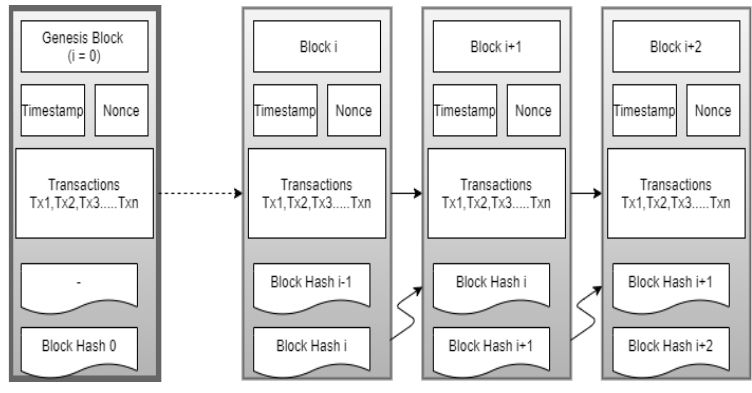
Figure 6. A simple blockchain [58].